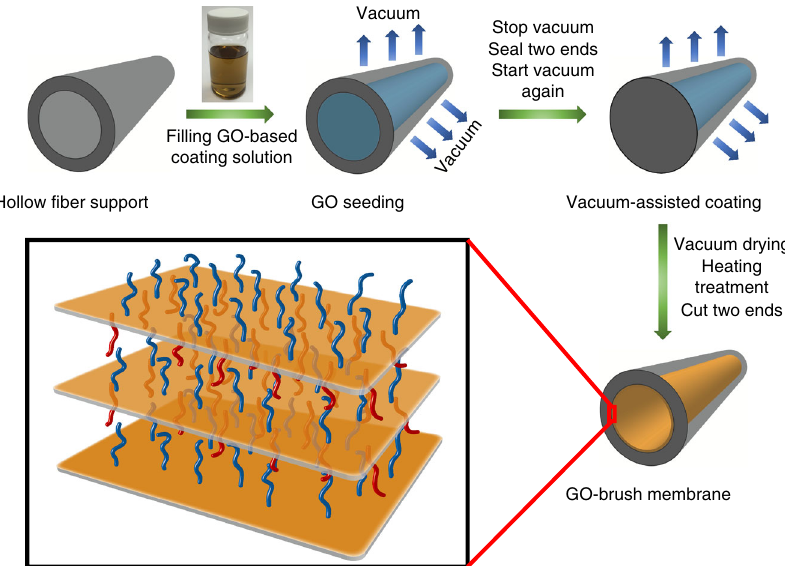
Fig. 1 Fabrication process and structure diagram of the ultrathin GO-based hollow fi ber membranes with brush-like CO 2 -philic agent. The blue brushes denote the grafted agents on the top surface of GO, and the red brushes denote the grafted agents on the bottom surface of GO. The brushes can be appropriate CO 2 -philic agents that are able to chemically bond with the GO surface by reacting with oxygen-functional